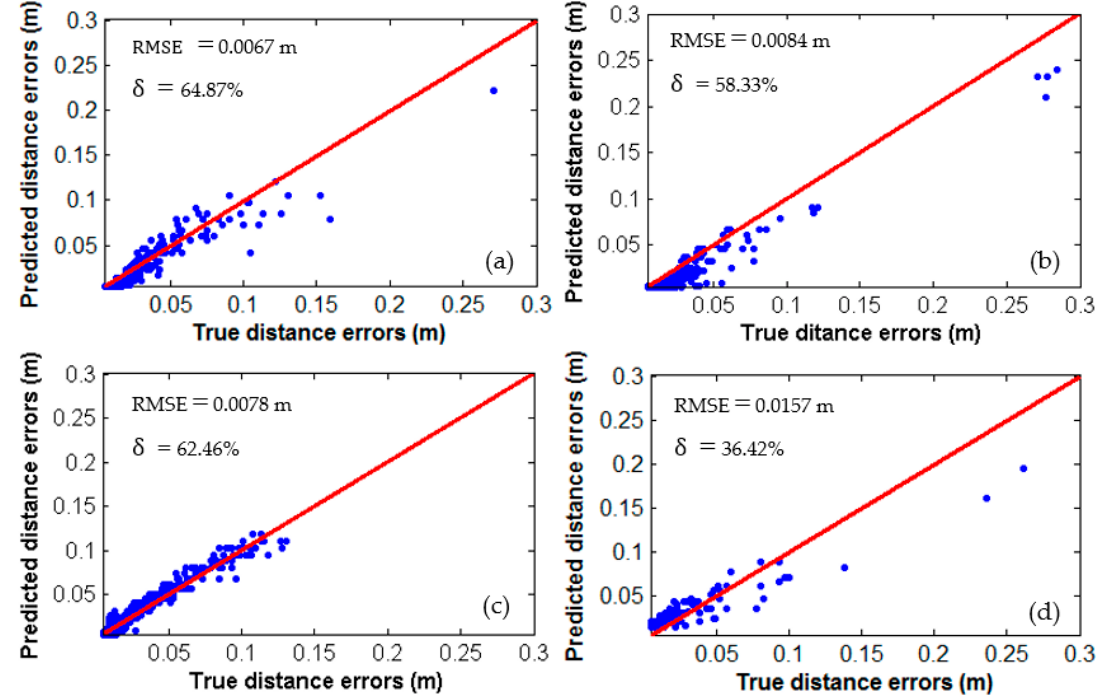
Figure 7. Predicted and true distance errors: ( a ) polyvinyl chloride sheet; ( b ) paint steel plate; ( c ) polished aluminum alloy door; ( d ) rubber advertising board. The equation of the red lines is y = x . RMSE is the root mean square error and δ is a parameter that indicates the degree of distance measurement accuracy improvement.